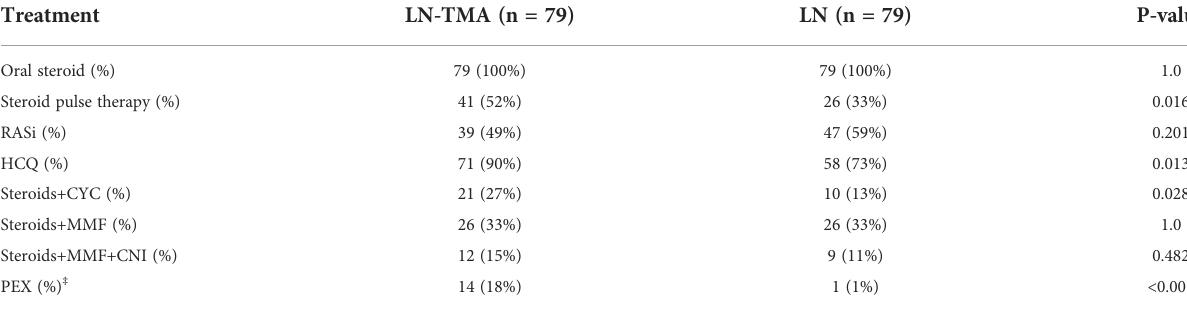
TABLE 4 Treatment of lupus nephritis patients with or without renal thrombotic microangiopathy. Treatment